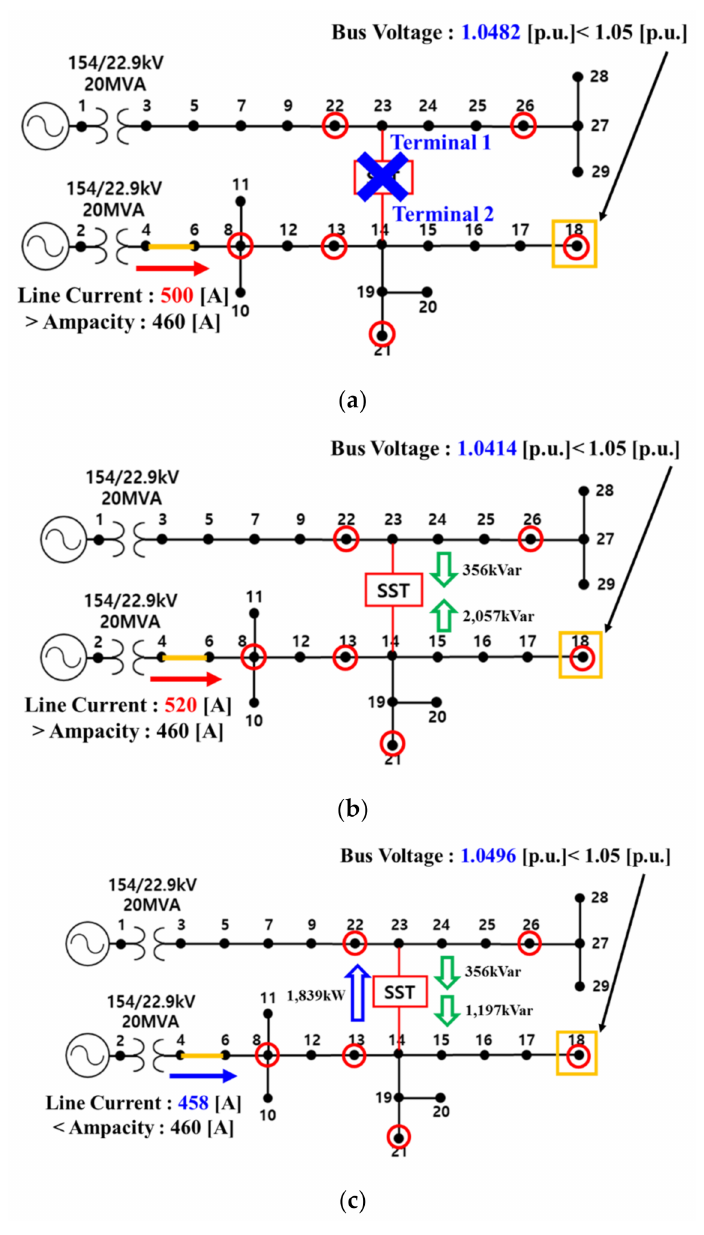
Figure 9. SST power flow at Table 2 conditions at 13:00 p.m.: ( a ) without the SST; ( b ) only the Volt/Var function of the SST; ( c ) proposed control of the